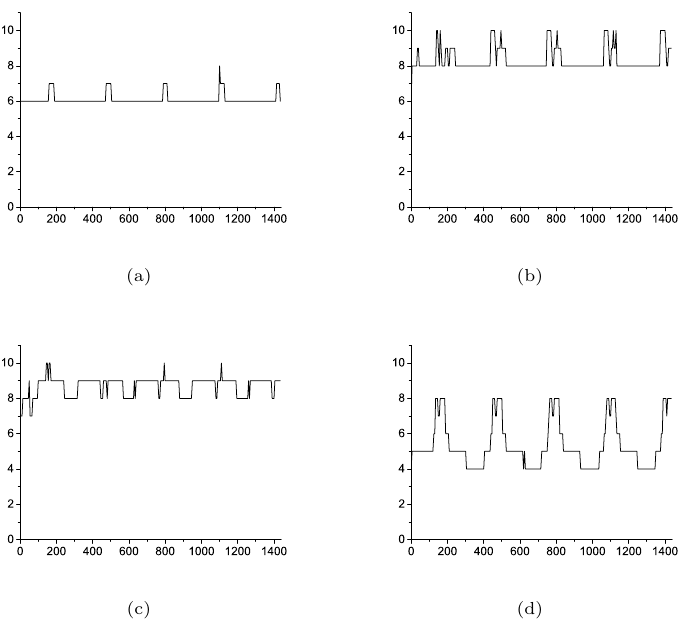
Figure 1. Number of Newton iterations: (a) N = 4, (b) N = 8, (c) N = 16, (d) N = 32.